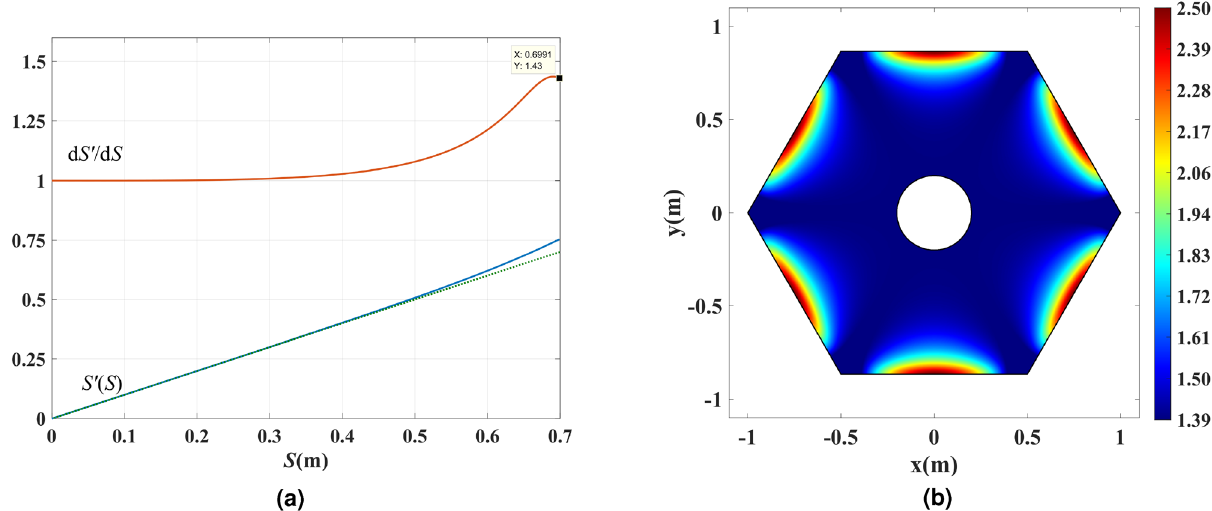
Figure 5. ( a ) The scaling function S ′ ( S ) and its derivative d S ′ / d S . ( b ) The refractive index of the hexagonal physical space in Fig. 3d after rescaling the optical path for mitigating the superluminal regions and applying index